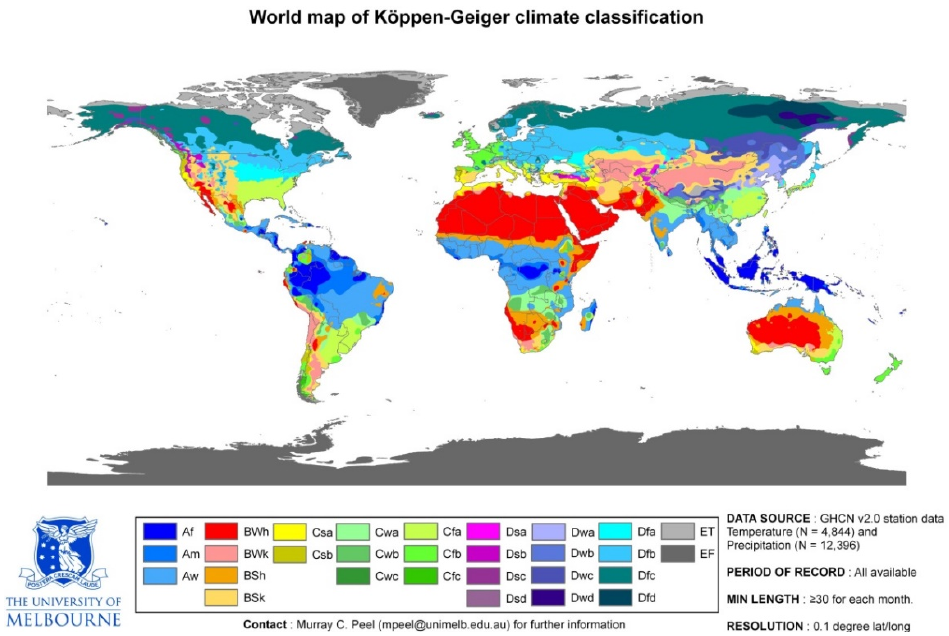
Figure 1. Köppen climate classification map [56]. Regions belonging to classes from B (Hot desert climates) to Cs (Mediterranean climate) could use the potential of the green structure the most.